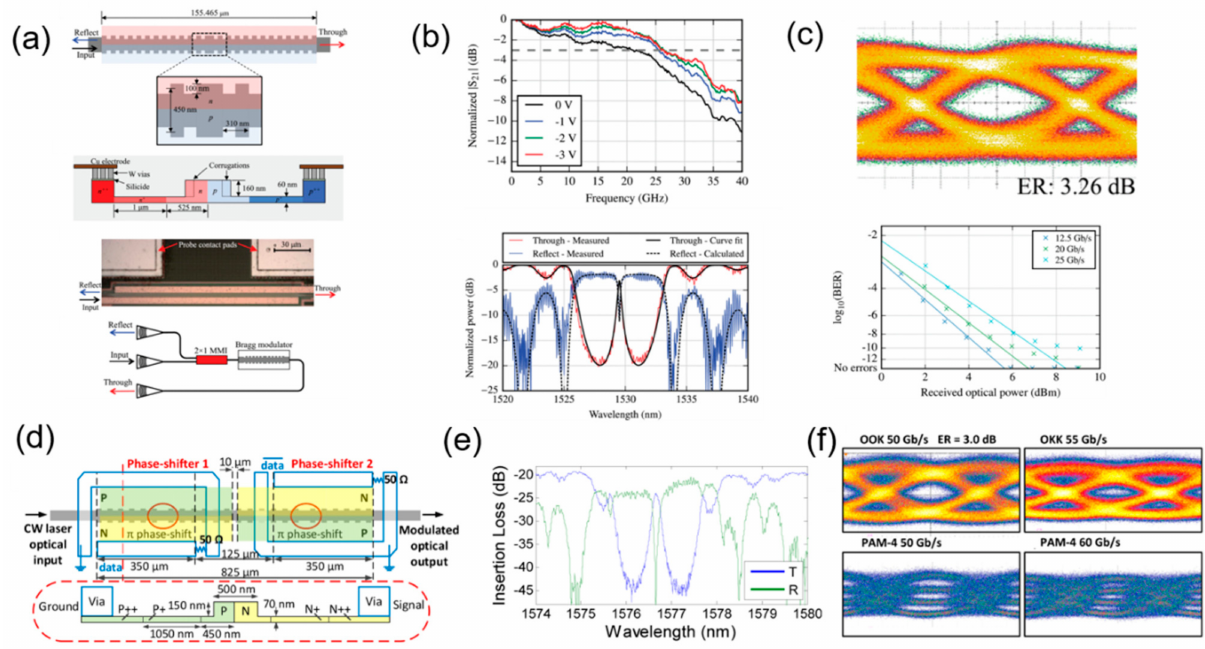
Figure 13. The structure and performance of silicon modulator with Bragg grating. ( a ) Schematic and optical image of the silicon modulator with quarter-wave phase-shifted Bragg grating resonator [67]. ( b ) EO bandwidth and spectra of the quarter-wave phase-shifted Bragg grating modulator [67]. ( c ) OOK of 32 Gb/s and BER curve of the quarter-wave phase-shifted Bragg grating modulator [67]. ( d ) Schematic of the dual phase-shift Bragg grating modulator [68]. ( e ) Spectra at different voltages of the dual phase-shift Bragg grating modulator [68]. ( f ) OOK and PAM-4 eye diagram of the dual phase-shift Bragg grating modulator